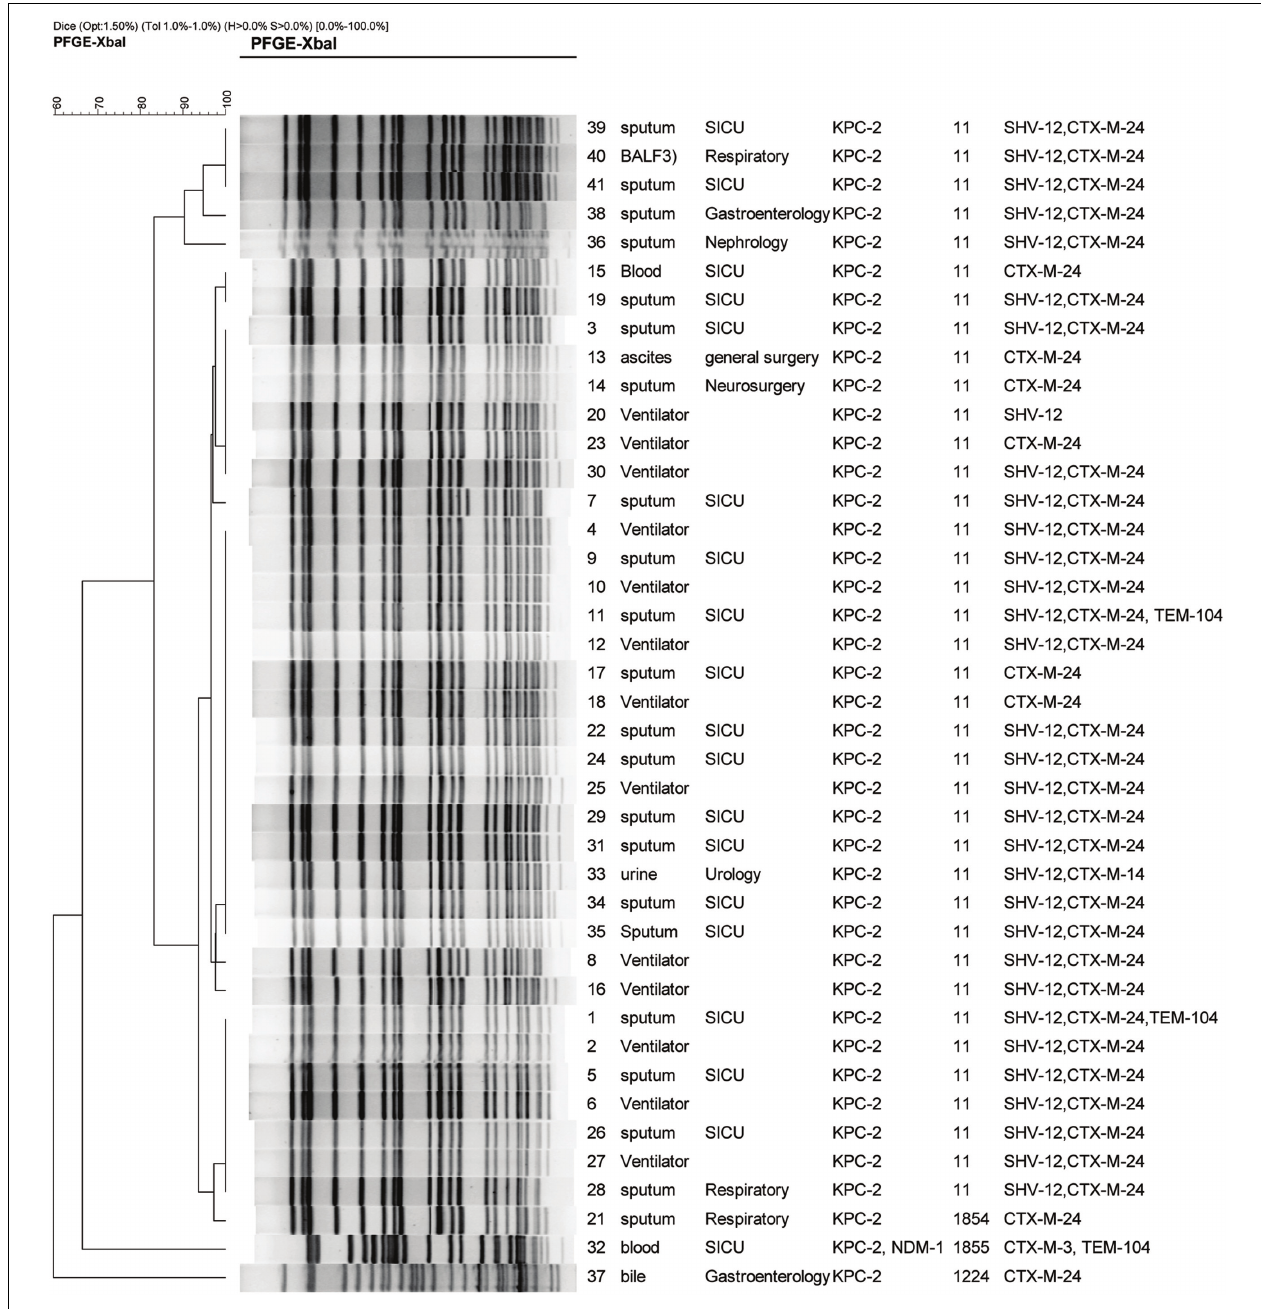
FIGURE 1 | Dendrogram of patterns for carbapenem-resistant K. pneumonia isolates obtained by PFGE. SICU, surgical intensive care unit; BALF, bronchoalveolar lavage fluid; ST, sequence type; ESBLs, extended-spectrum beta-lactamases.